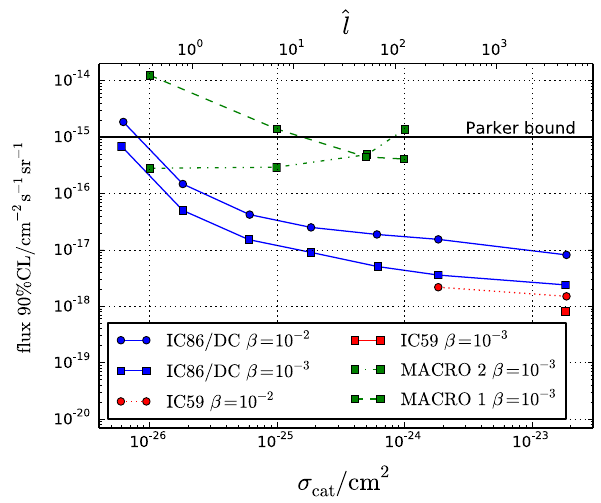
Fig. 1 Correction of Fig. 20 in Ref. [1] showing the upper limits on the flux of non-relativistic magnetic monopoles depending on the speed β and catalysis cross section σ cat of the IC-59 analysis and IC- 86/DeepCore analysis. The dashed lines are limits published by the MACROexperiment[3].Thecatalysiscrosssection σ cat isderivedfrom the simulated mean free path λ cat using the number density of nucleons in the water molecule in Eq. 1. Thus, the cross section, shown here, can be interpreted as the number averaged cross section per nucleon. The theoretical catalysis cross section of nucleons bound in hydrogen and oxygen is different and dependent on the monopole velocity, see Eq. 2 and Ref. [2]. Here, MACRO 1 is an analysis developed for monopoles catalyzing the proton decay. MACRO 2 is the standard MACRO anal- ysis, which is sensitive to monopoles ionizing the surrounding matter. Additionally, the IceCube limits are shown as a function of ˆ l which is proportional to the averaged Cherenkov photon yield per nucleon decay (not valid for MACRO